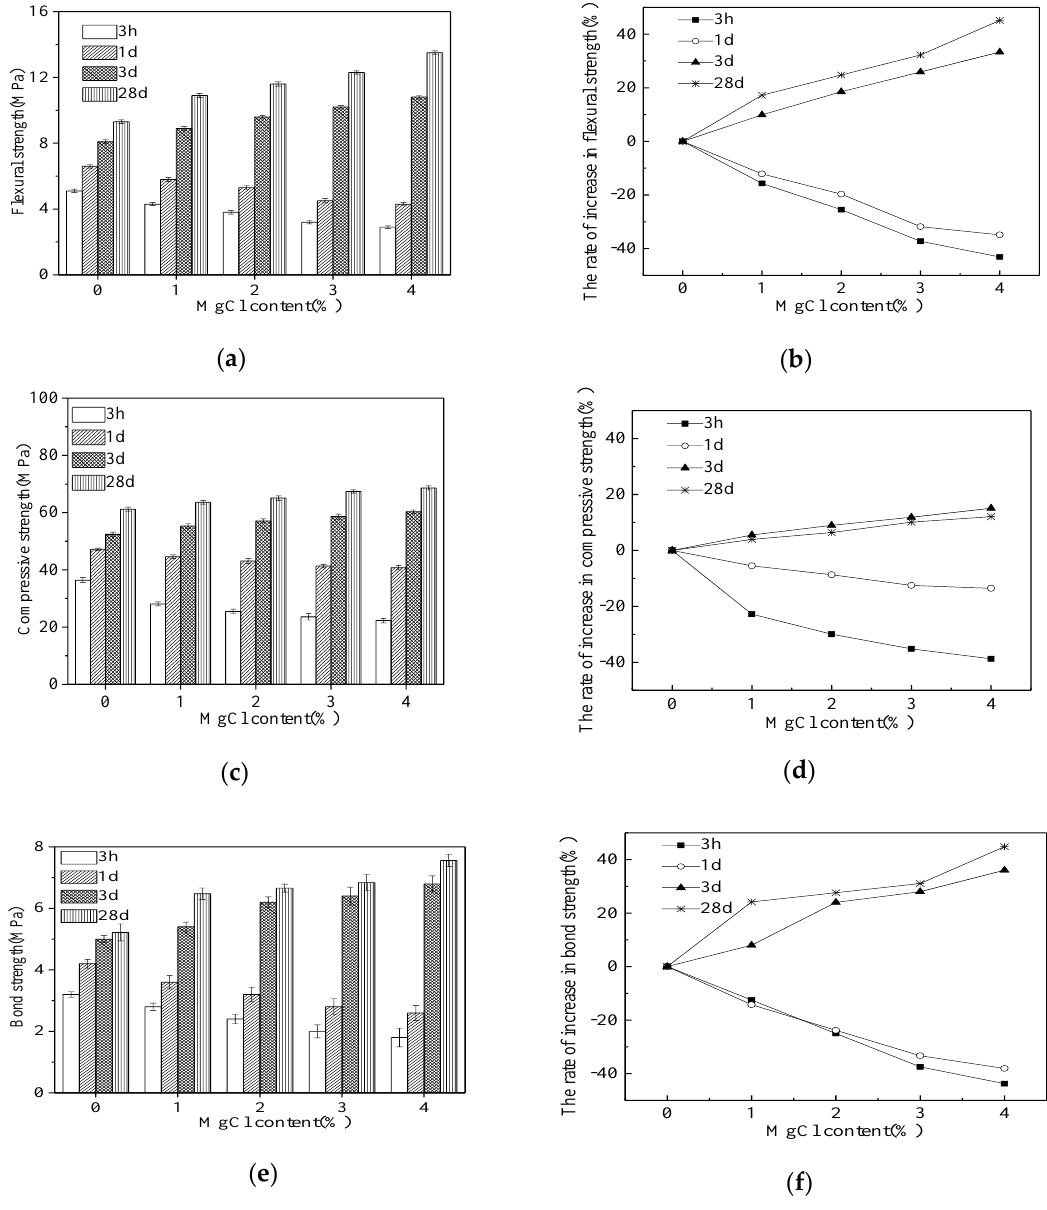
Figure 7. The mechanical strengths and the corresponding increasing rate of cement paste at different curing age. ( a ) Flexural strength, ( b ) The increasing rate of flexural strength by MgCl, ( c ) Compressive strength, ( d ) The increasing rate of flexural strength by MgCl, ( e ) Bond strength, ( f ) The increasing rate of flexural strength by MgCl.